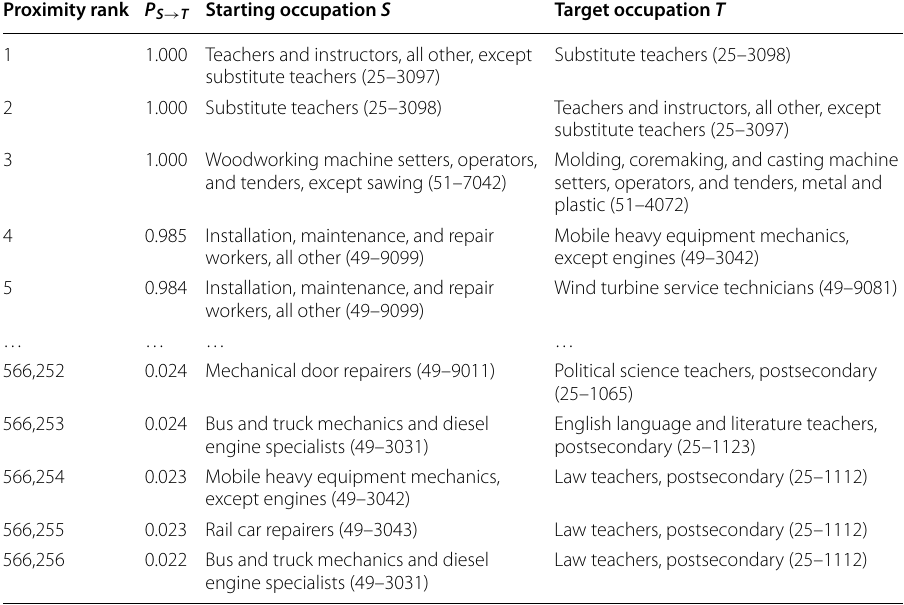
Table 2 Highest five and lowest five occupation proximity values P S → T between occupation pairs Proximity rank P S → T Starting occupation